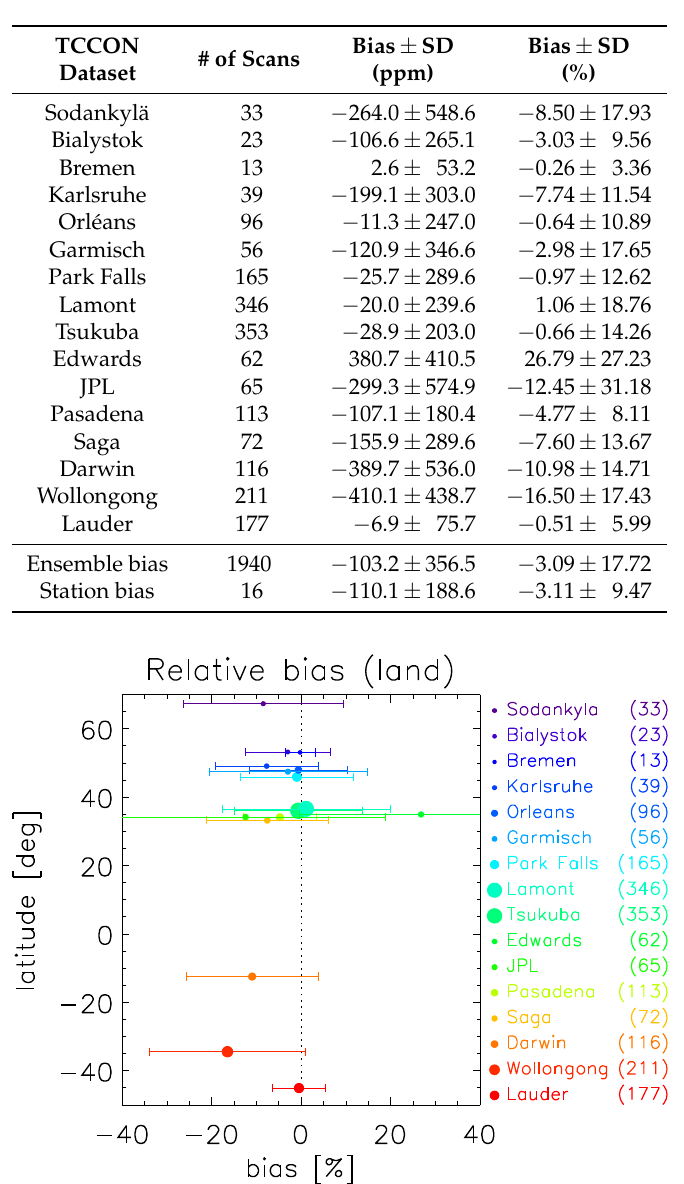
Table 2. Results of the comparison between TANSO-FTS scans acquired within ± 1 ◦ in latitude and in longitude of the TCCON sites and the average of TCCON measurements within ± 30min of the corresponding GOSAT overpasses. The number of matched scans is given. The absolute and relative values of the mean bias and standard deviation (SD) are indicated for each station. The ensemble and site-by-site results are also given.